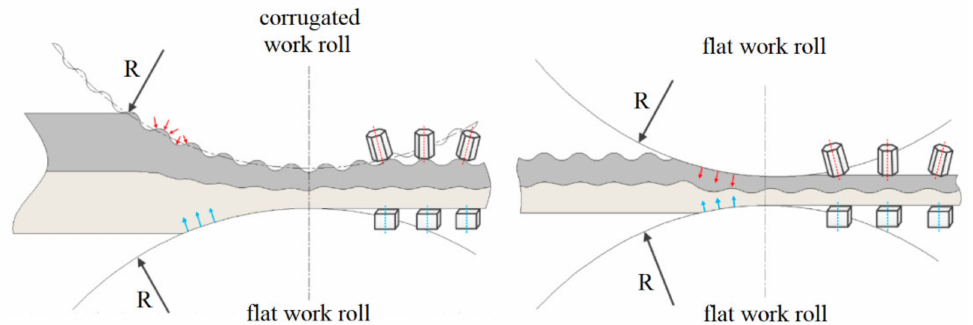
Figure 13. Schematic illustration showing the shear stress during the corrugated rolling and flat rolling process